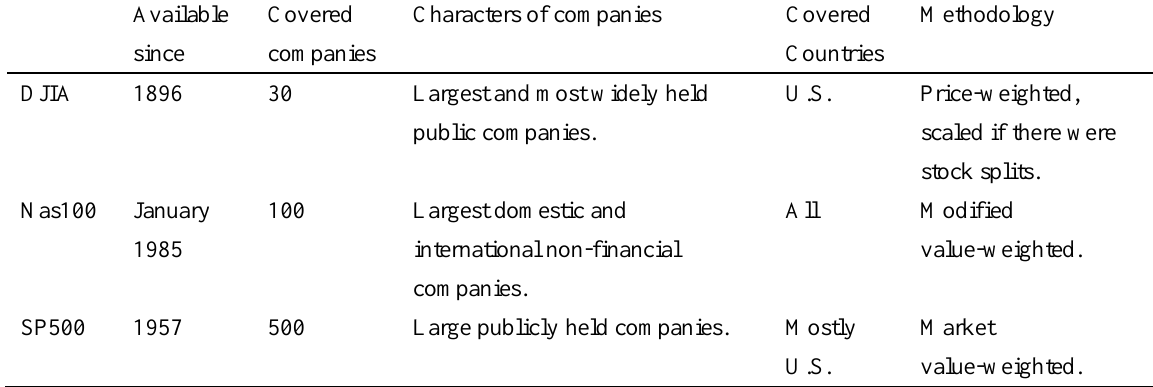
Table 1: Summary and Comparison of Three Major U.S. Stock Indices